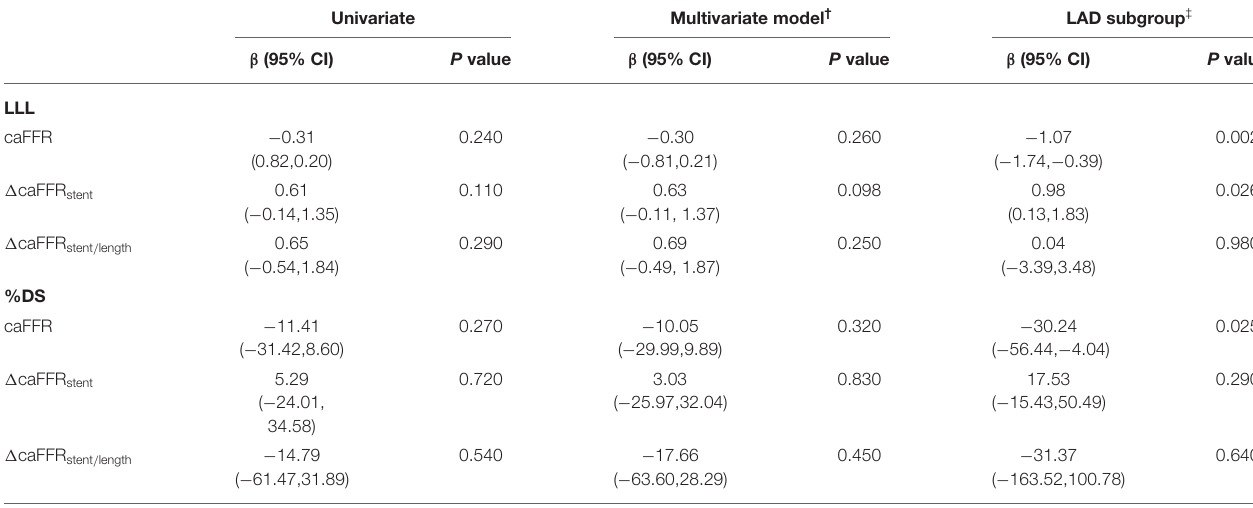
† Multivariate model adjusting for age, gender and diabetes mellitus. ‡ Multivariate model adjusting for age, gender and diabetes mellitus applied to the subgroup with lesions located in LAD. 95% CI, 95% confidence interval; LLL, late lumen loss; %DS, percent diameter stenosis; LAD, left anterior descending artery; caFFR, coronary angiography-derived fractional